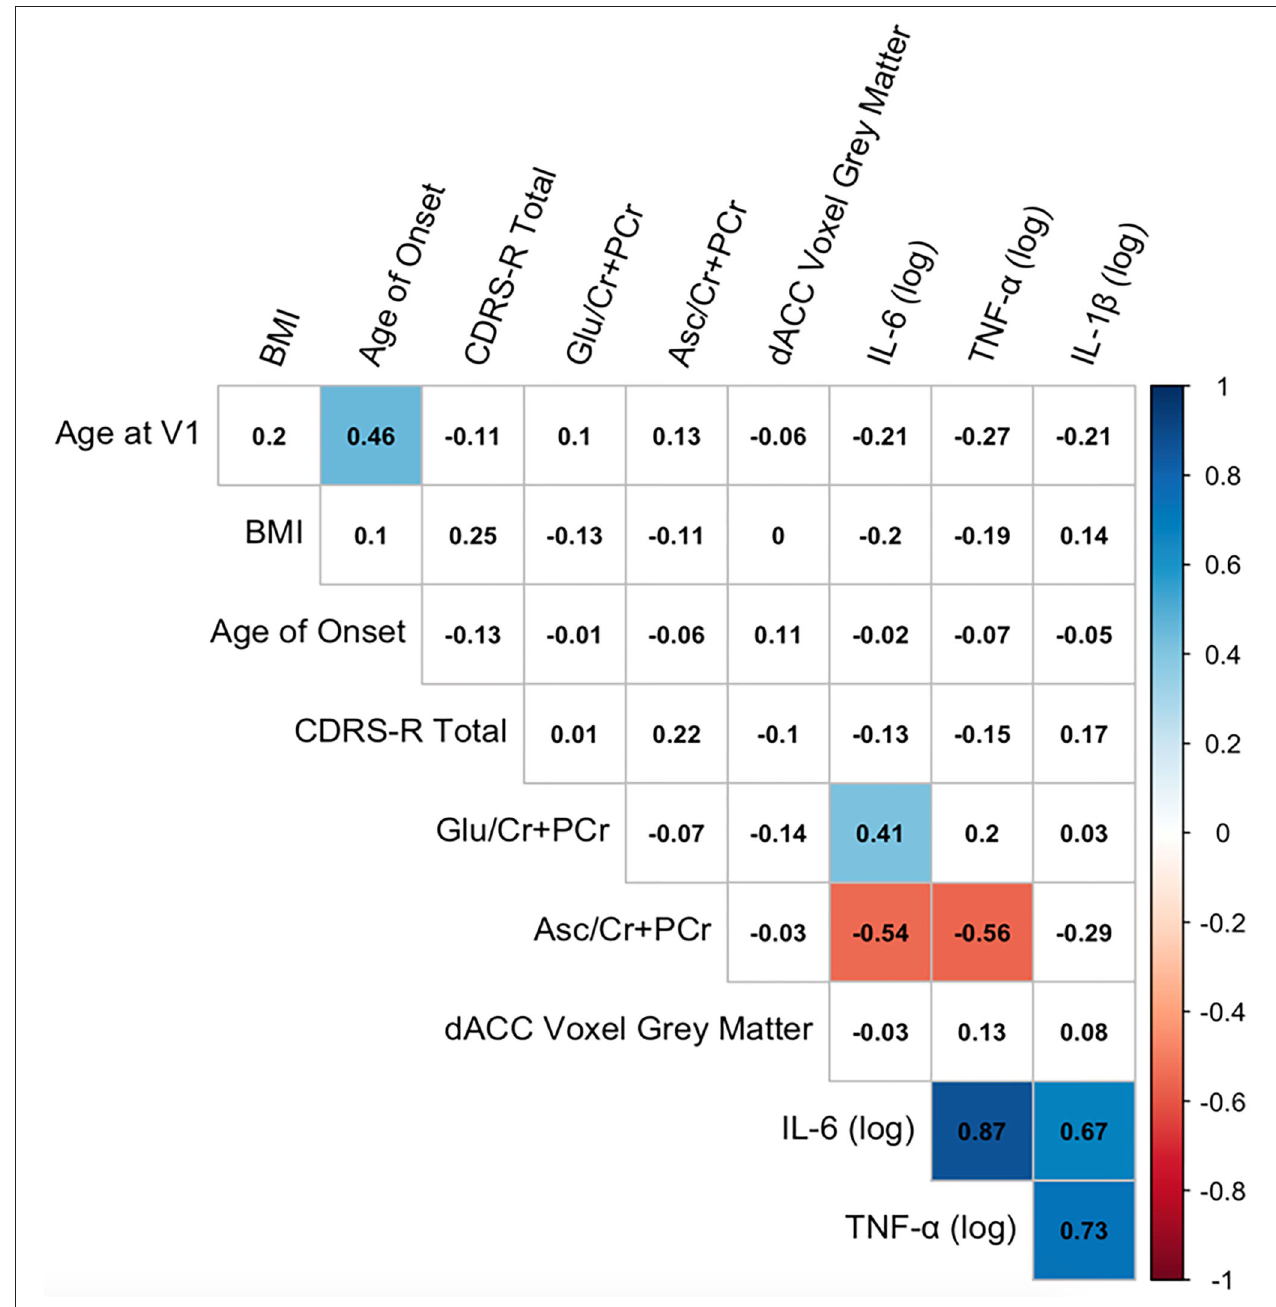
FIGURE 2 | Correlation matrix among key variables of interest. Correlation matrix of primary predictor and outcome variables of interest, covariates, and clinical characteristics. Pearson correlation coefficients are presented in black text. Significant correlations at p < 0.05 (uncorrected) are highlighted in color (blue, positive correlations; red, negative